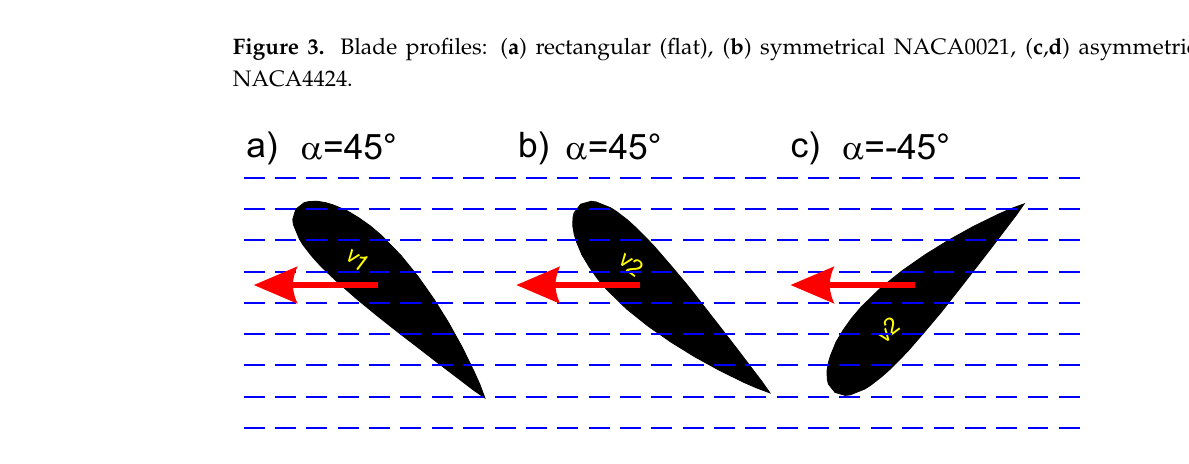
Figure 3. Blade profiles: ( a ) rectangular (flat), ( b ) symmetrical NACA0021, ( c , d ) asymmetrical NACA4424.